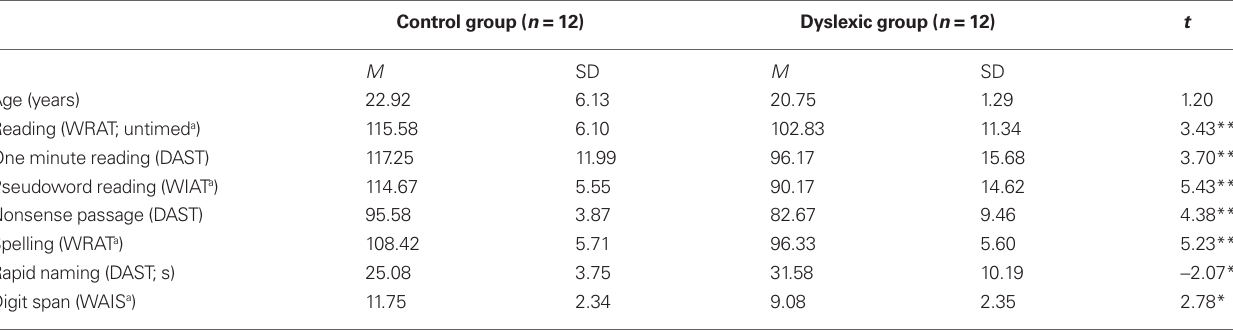
Table 1 | Group performance on psychometric